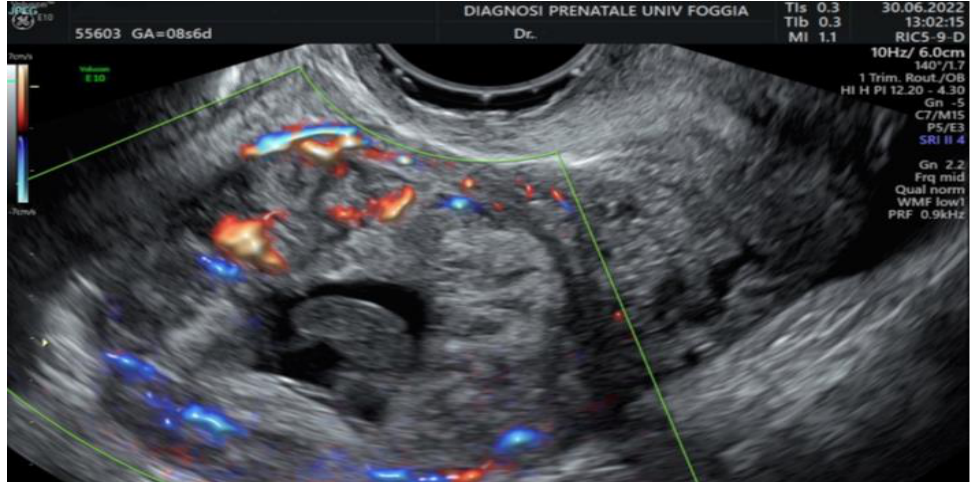
Figure 5. Transvaginal ultrasound control performed on day 15.